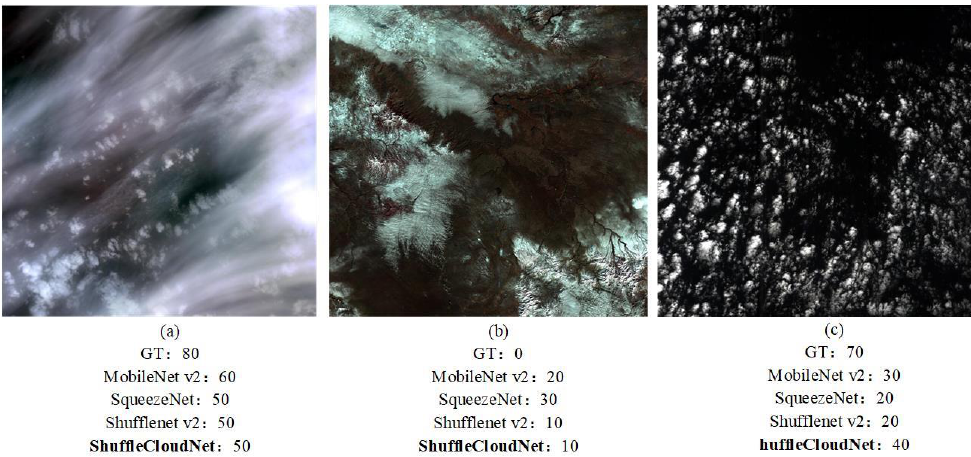
Figure 11. Example diagram of poor cloud-amount calculation results. (a) is an example of the cloud amount calculation result of remote sensing image with thin cloud covering thick cloud. ( b ) is an example of cloud amount calculation result of remote sensing image of ice snow cloud trast in the evening.